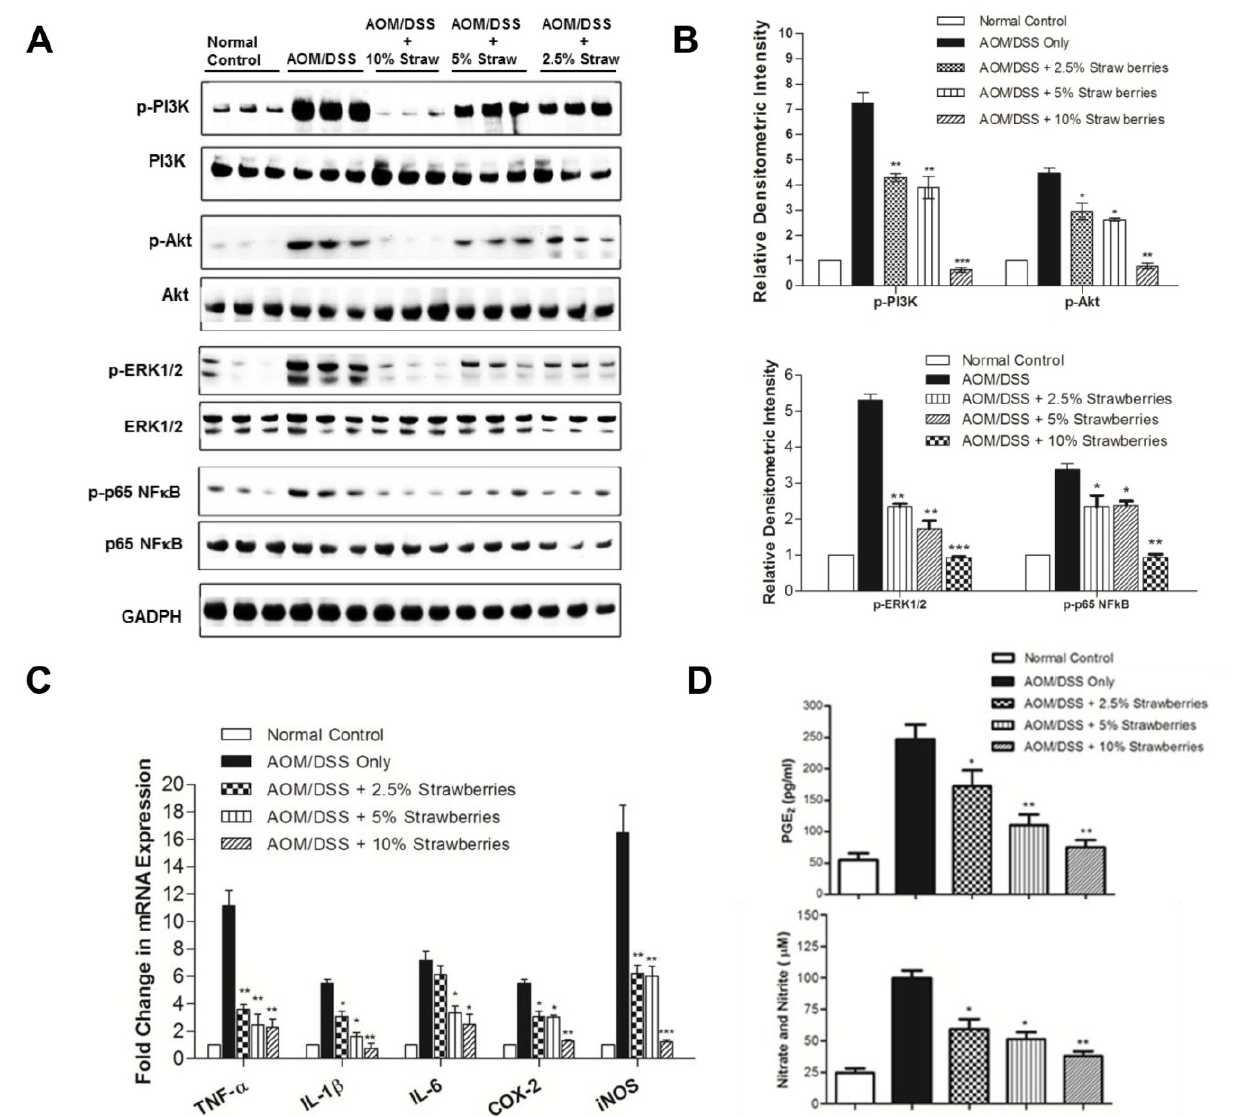
Figure 3. Western blot analysis of effects of strawberries on PI3K/Akt, ERK and NFκB (A,B). Strawberries decrease phosphorylation of PI3K/Akt, ERK1/2 and activation of NFκB. Samples were probed with antibodies against p-PI3K, p-Akt, p-ERK1/2 or p-p65 NFκB. The Western blot membranes were stripped and reprobed for GADPH as an internal control to confirm equal loading. ( A ) representative blots from one of three separate experiments; ( B ) relative densitometric intensity; ( C ) real-time PCR analysis of the inhibitory effects of strawberries on mRNA expression of TNF-α, IL-1β, IL-6, COX-2 and iNOS; and ( D ) inhibitory effects of strawberries on the production of PGE 2 and NO. Columns , mean; bars , ± SE; * p < 0.05, ** p < 0.01, *** p < 0.001 versus animals treated with AOM/DSS fed control